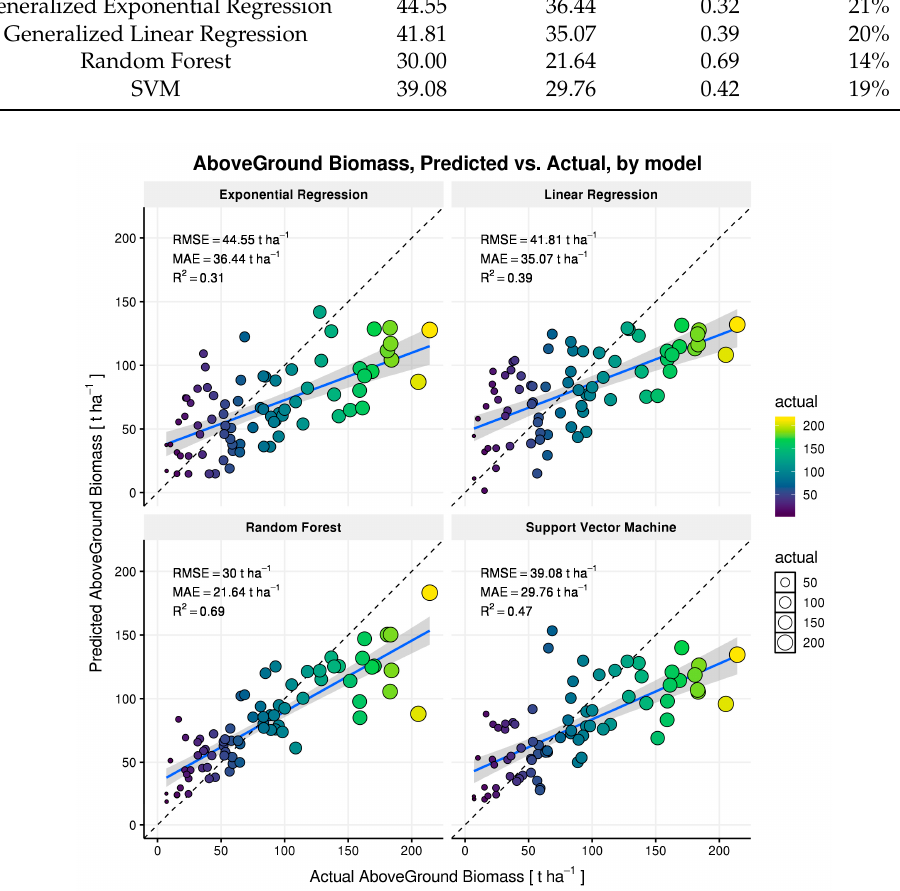
Figure 6. Scatterplot of predicted vs. modelled AGB in tha − 1 for the four models using the independent validation dataset. Both circle size and colour refer to the actual AGB. Model performance indicators are also shown in Table 4. The blue line indicates the linear regression between the actual and modelled data and the grey area is the 95% confidence level interval.